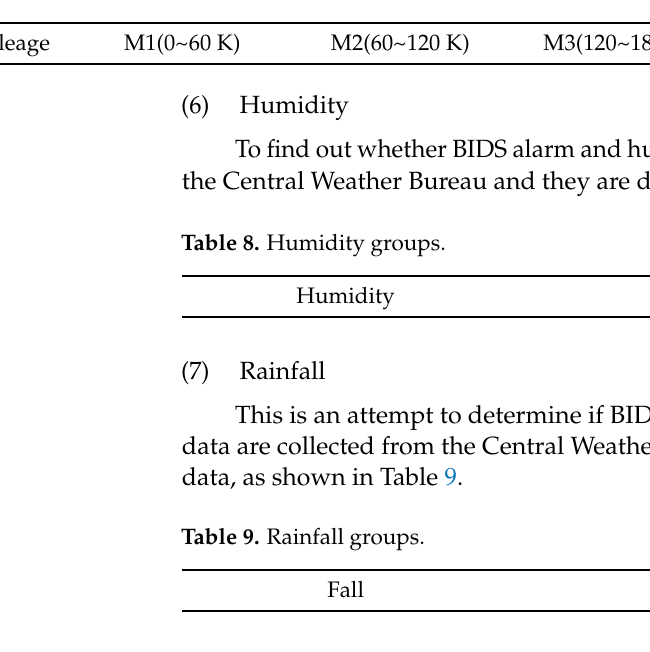
Table 7. Trainset accumulated mileage groups.